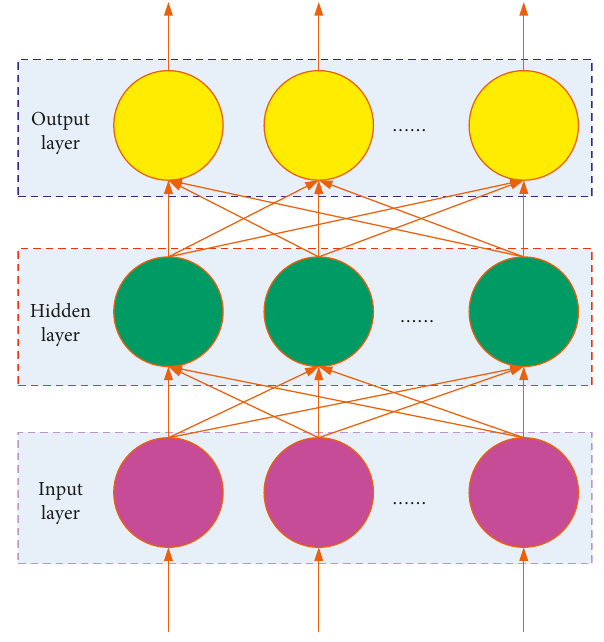
Figure 4: Forward neural network